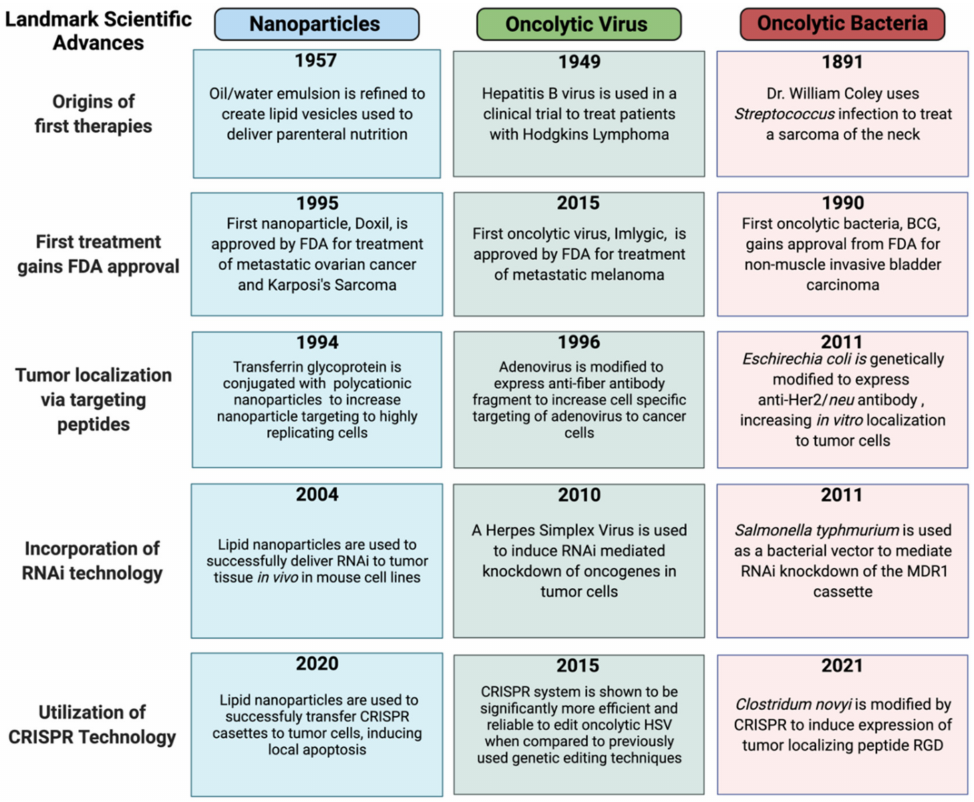
Figure 7. Significant milestones for the development of nanoparticles, oncolytic viruses, and oncolytic bacteria as oncotherapies. References—NP: [344,346,361]. OV: [74,361–365]. OB: